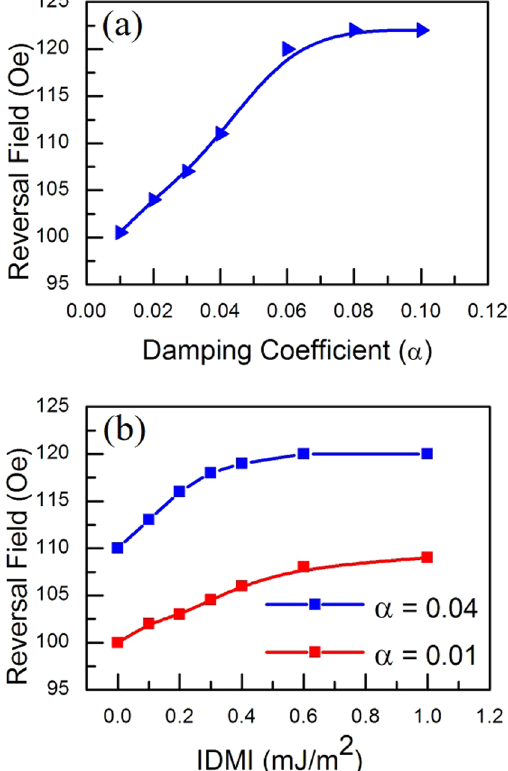
Figure 5. Reversal field calculated from hysteresis loops obtained in the micromagnetic simulations. By varying the damping the reversal field goes up, reaches a plateau, which is consistent with experimental data observed in Fig. 4(a). Simulations were also performed varying IDMI using two damping values. Both the reversal fields as a function of IDMI show a smaller influence on the DW propagation, though for higher damping the IDMI has a more important contribution to the reversal field